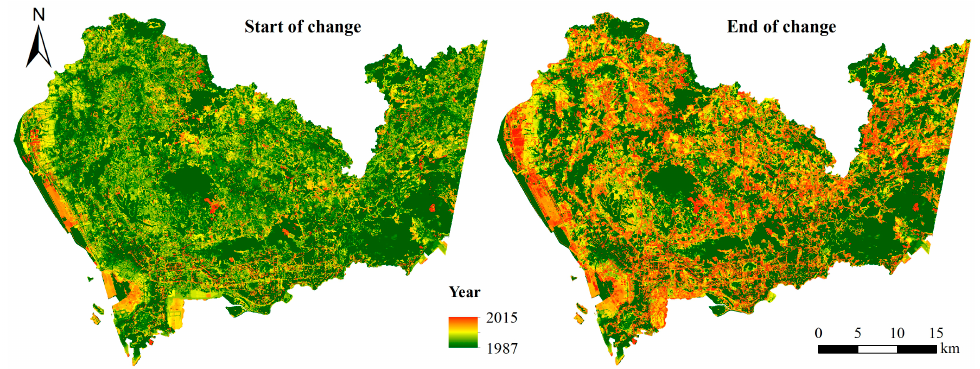
Figure 4. Start and end year of landscape transformation portrayed pixel-by-pixel.